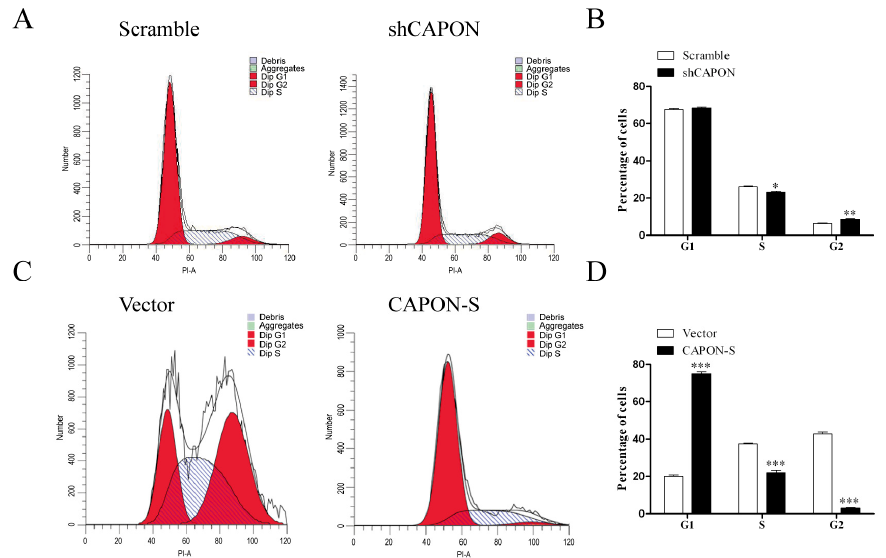
Figure 4. Effects of CAPON-S on the cell cycle progression in glioma cells. Flow cytometry was employed to analyze the cell cycle progression in CAPON-silencing C6 cells and CAPON-S-overexpressing U87 cells. Representative histograms for C6 and U87 cells are shown in A and C , respectively. The percentages of cells at each stage of cell cycle are shown in B (C6) and D (U87) (* p < 0.05; ** p < 0.01; *** p < 0.001).